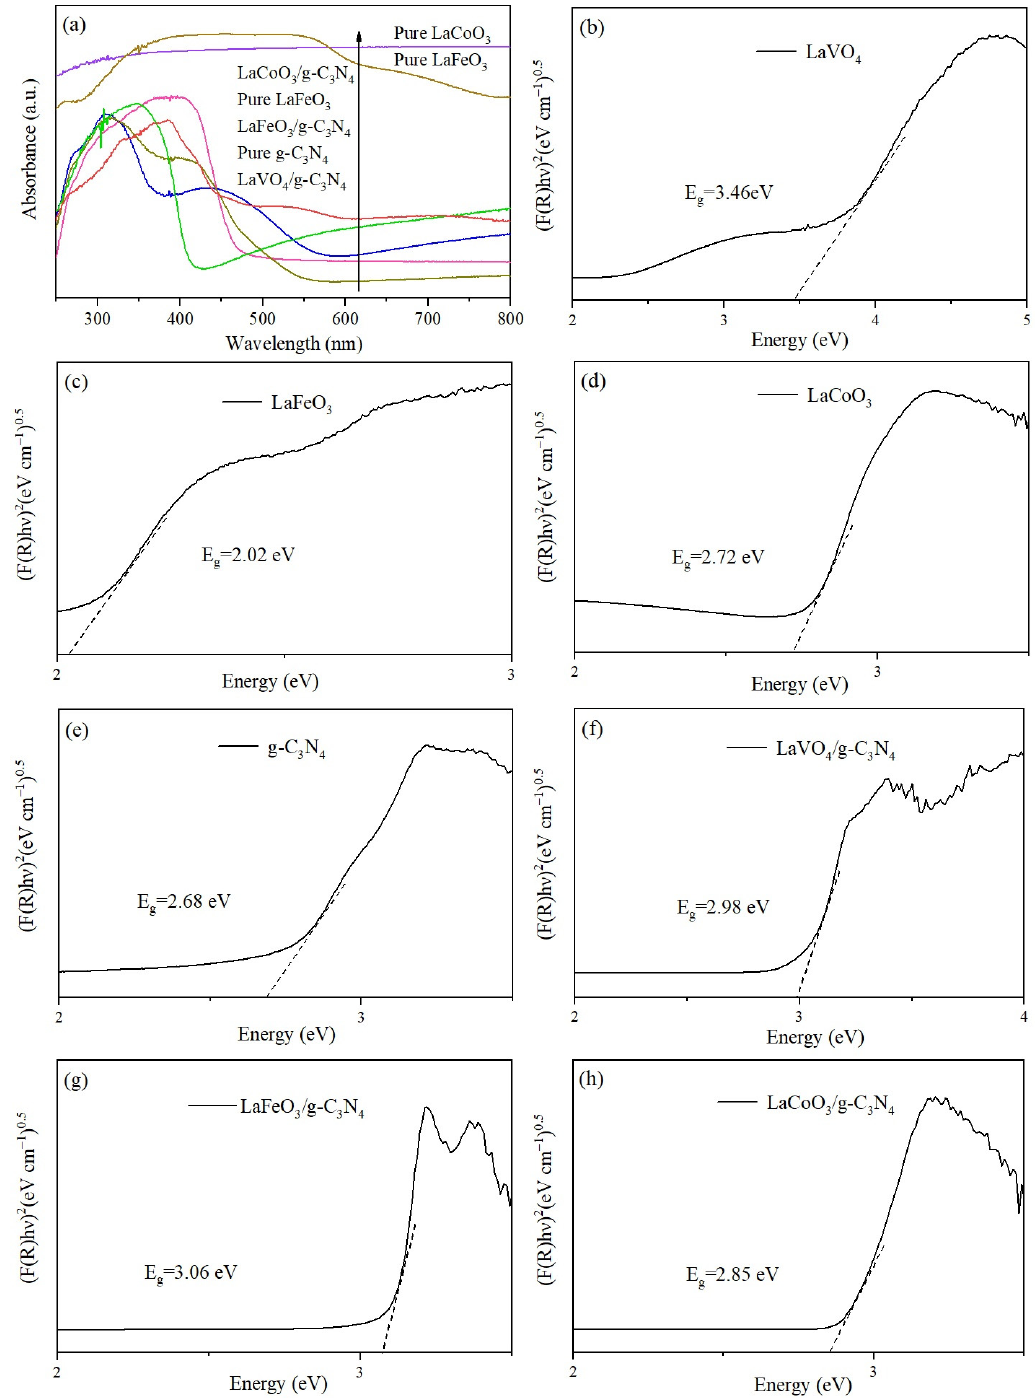
Figure 5. ( a ) DRS spectra of g-C 3 N 4 , LaVO 4 , LaFeO 3 , LaCoO 3 , and LaAO x /g-C 3 N 4 (A = V, Fe, Co) composite photocatalyst and the band gaps of ( b ) LaVO 4 , ( c ) LaFeO 3 , ( d ) LaCoO 3 , ( e ) g-C 3 N 4 , ( f ) LaVO 4 /g-C 3 N 4 , ( g ) LaFeO 3 /g-C 3 N 4 , and ( h ) LaCoO 3 /g-C 3 N 4